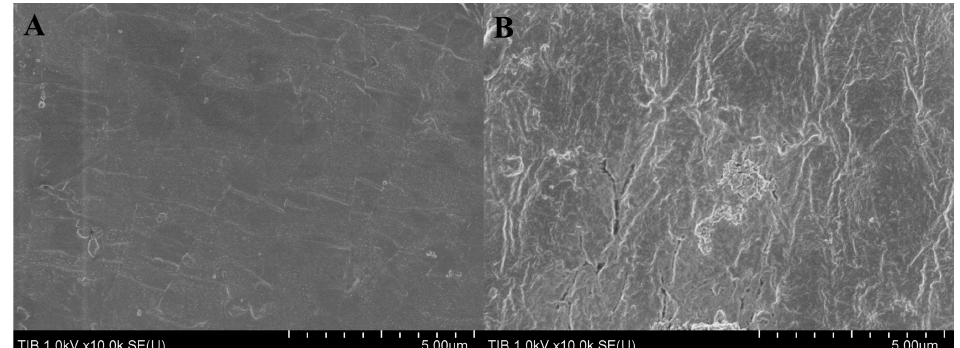
Figure 4. SEM captures of PBAT film surface with and without treatment by Tcca. ( A ) SEM images (10,000 × magnification) for control PBAT film without enzymatic treatment; ( B ) PBAT film after incubation with Tcca. All SEM images were captured after 48 h of incubation at an enzyme loading of 2 mg/mL in 100 mM PBS buffer (pH 8.0) at 40 °C or with only buffer as a negative control.